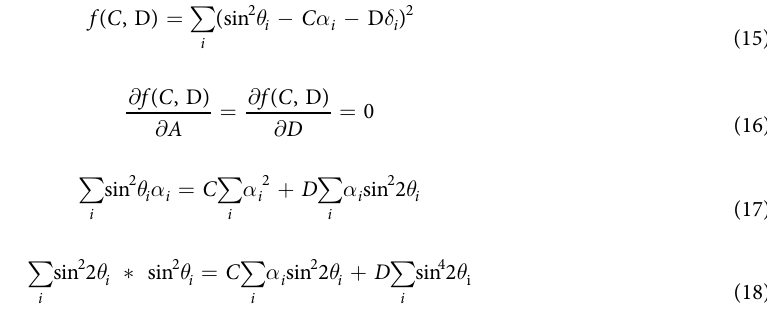
Obviously, the lattice parameter ( α 0 ) can be determined from Eq. (12). α come from the corresponding peaks (h k l). The lattice parameters were given in Table 1.